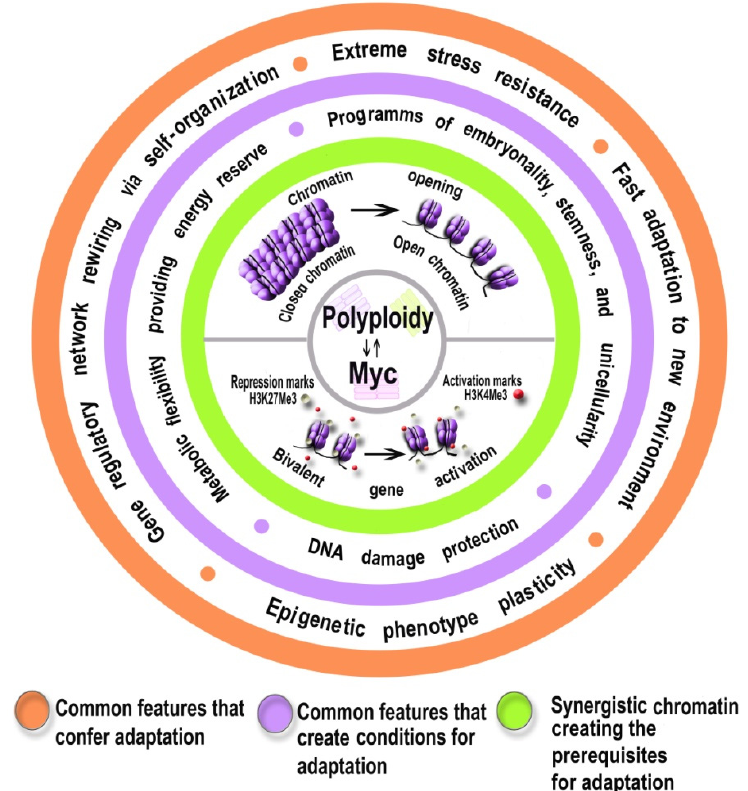
Figure 3. The most important common features of polyploidy and overexpressed Myc that promote resistance to extreme stress and confer the ability to rapidly adapt to new environments.